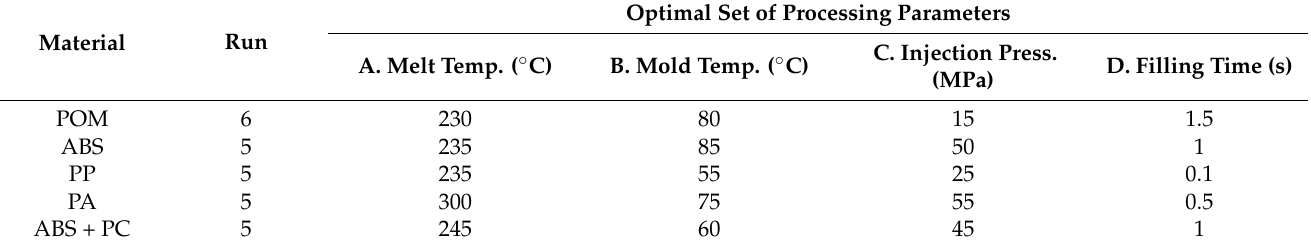
Table 7. The processing conditions of warpage of the micro-sized part with various plastics based on grey relational